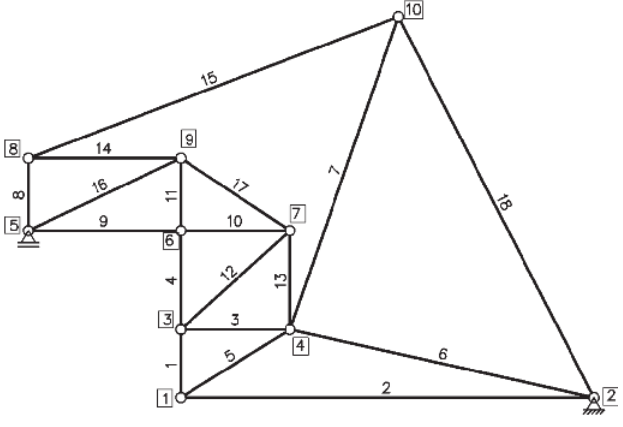
Strut-and-tie model with nodes and member